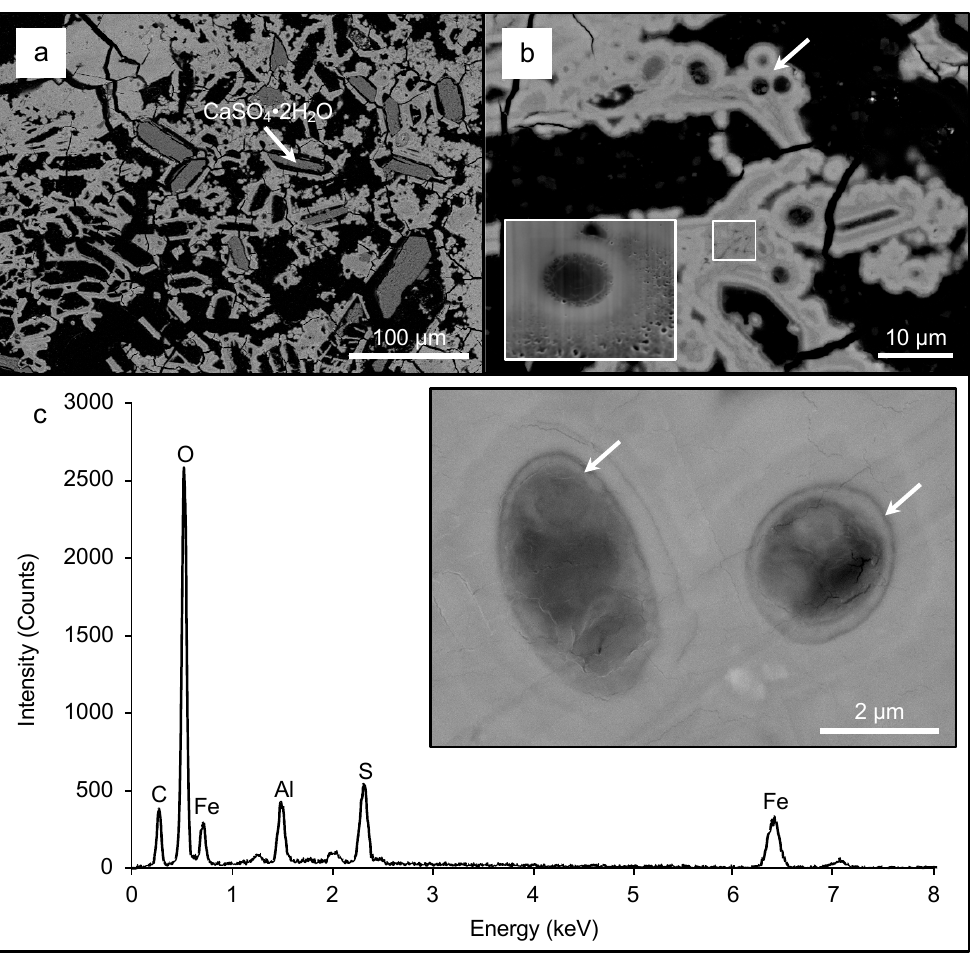
Figure 8. A low-magnification BSE SEM micrograph of schwertmannite/goethite on the outer surface of the gypsum crystals from the middle region. Note the pseudoporous texture of the IOM when gypsum crystals are missing ( a ). A high-magnification BSE SEM micrograph of the pseudoporous IOM containing microfossils. Note that the arrow and box highlight microfossils with varying sizes. A high-magnification BSE SEM micrograph of a FIB-milled section is highlighted in the box. These molds occurred within pseudoacicular mineral ( b , inset). A high-magnification BSE SEM micrograph of larger microfossils with preserved cell walls (arrows) and a representative energy dispersive spectrometer (EDS) spectrum of the surrounding mineral matrix ( c ).